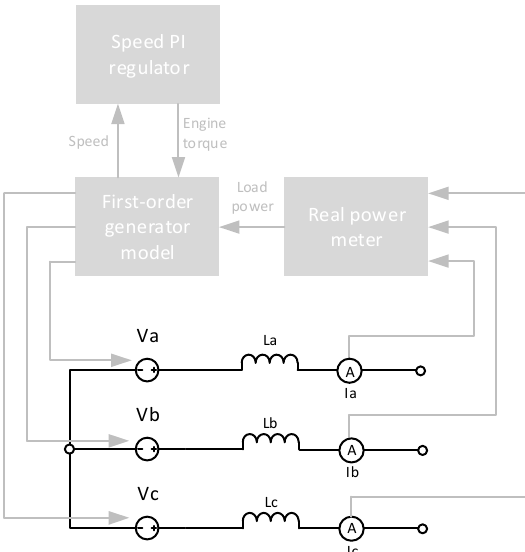
Figure 2. Block diagram of the diesel generator.